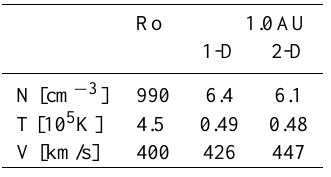
Table 1. Characteristics of the ambient solar wind. Initial condi- tions at the inner boundary (Ro=0.083AU) and stationary solutions at 1AU in one and two